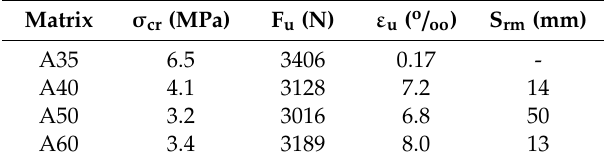
Table 3. Results from direct tension test on textile reinforced concrete (TRC).